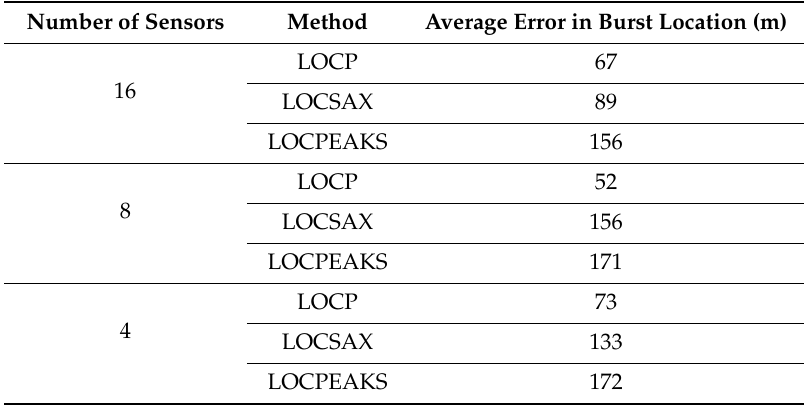
Figure 7. Clustering for the LOCP method using eight sensors in the Campos do Conde network. Table 3. Campos do Conde results with